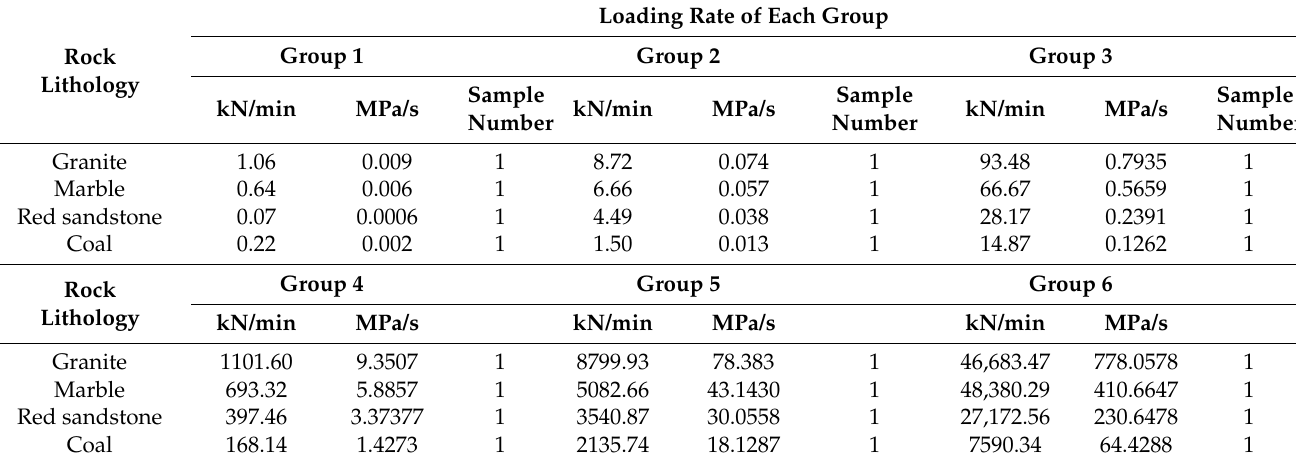
Table 2. Loading rate in load controlled uniaxial compression tests.